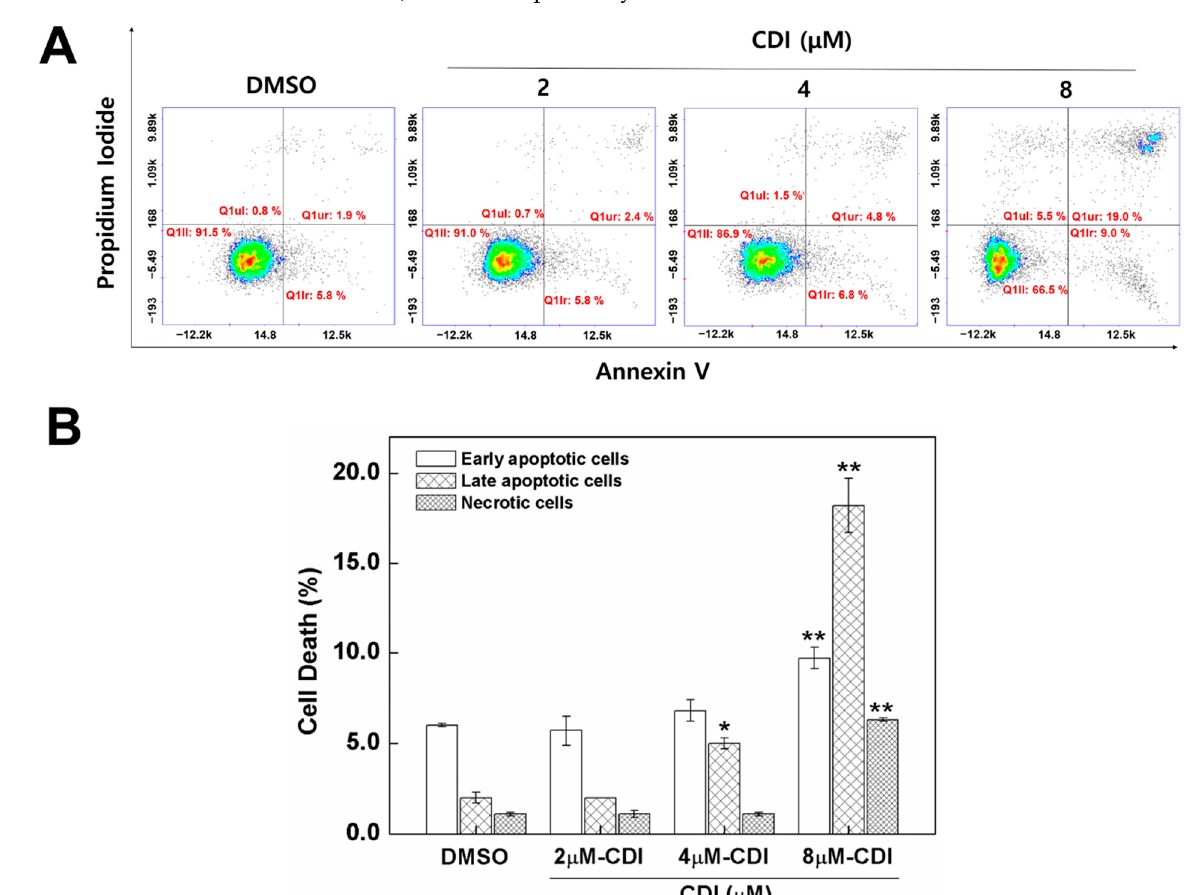
Figure 4. Effects of CDI on apoptosis and necrosis in MDA-MB-231 cell line. ( A ) MDA-MB-231 cells were treated with CDI concentrations of 2, 4, and 8 µ M for 24 h. Apoptotic loss of membrane asymmetry was analyzed by annexin V and propidium iodide double-staining. ( B ) Quantitative analysis ( n = 6) of apoptotic cells and necrotic cells using NucleoCounter ® NC3000TM (v2.1.25.12, Chemometec, Allerod, Denmark). DMSO-treated cells were used as control. Data are expressed as means ± SD ( n = 3). * p < 0.05 and ** p < 0.01 signifies which is significantly different from the DMSO control, respectively.